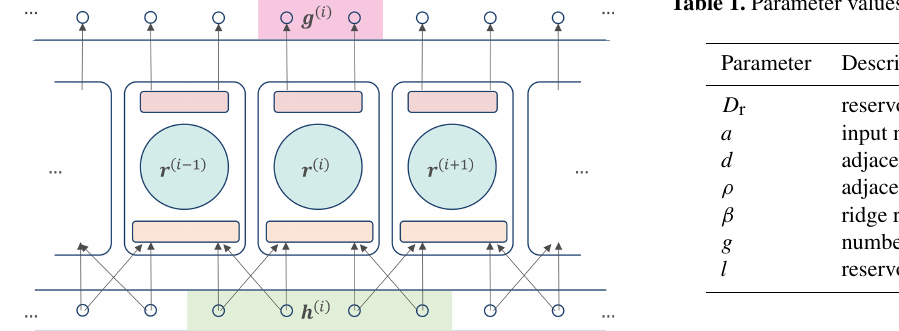
Table 1. Parameter values of RC used in each